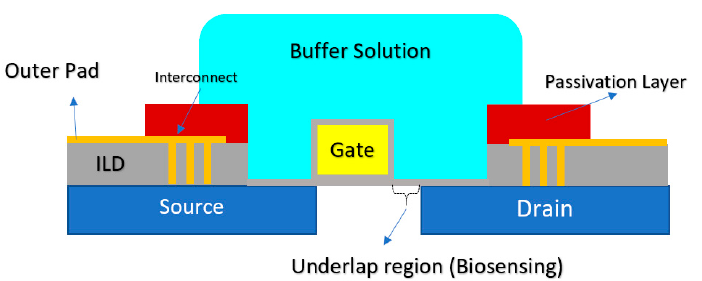
Figure 15. A CMOS-based Chem/BioFET structure using an underlap-FET biosensor: The cross- sectional of a water droplet is shown as the solution on top of the sensor. This sensor has been used to show the effect of wettability on the sensor characteristics and in particular sensitivity.